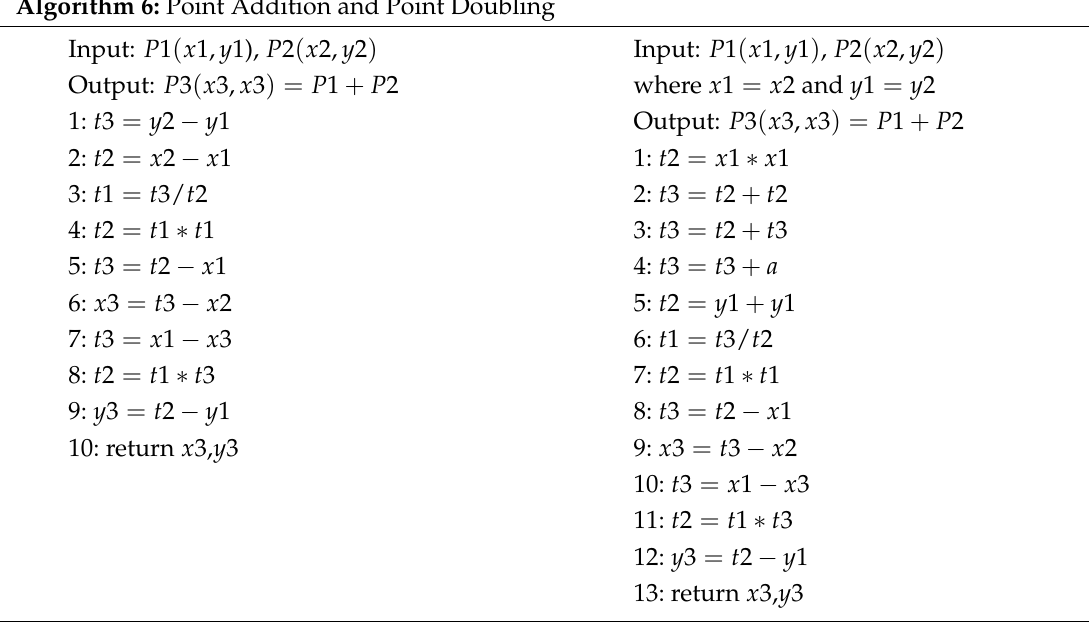
Algorithm 6: Point Addition and Point